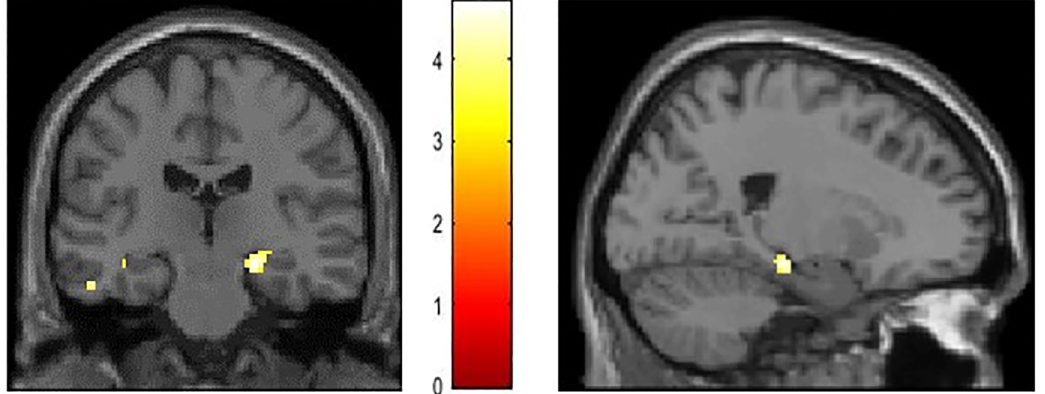
Fig 3. Statistical map thresholded at p < .001. Main effects of covariate show memory specific effects. Results indicate a positive relation between the amount of acquired knowledge (completion task scores) and significant effects within voxels in the right (-38, -22, -14) and left hippocampus (24, -22, -14) within the group of implicit participants (p < .05; FWE